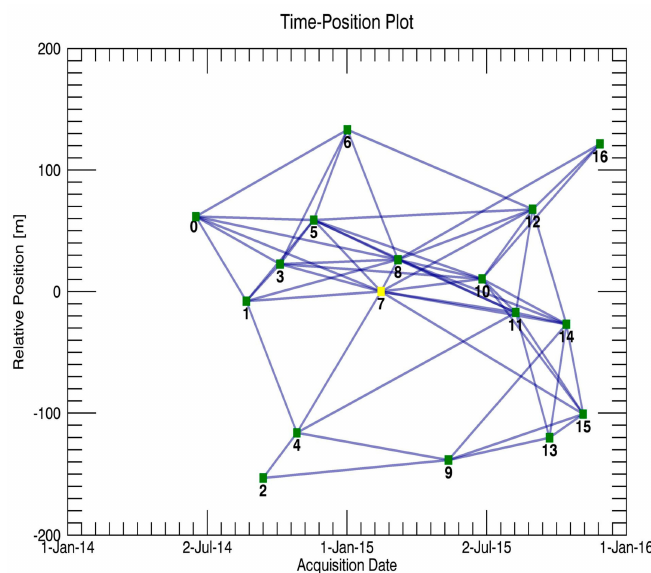
Figure 5. Temporal and perpendicular baselines of the available pairs.